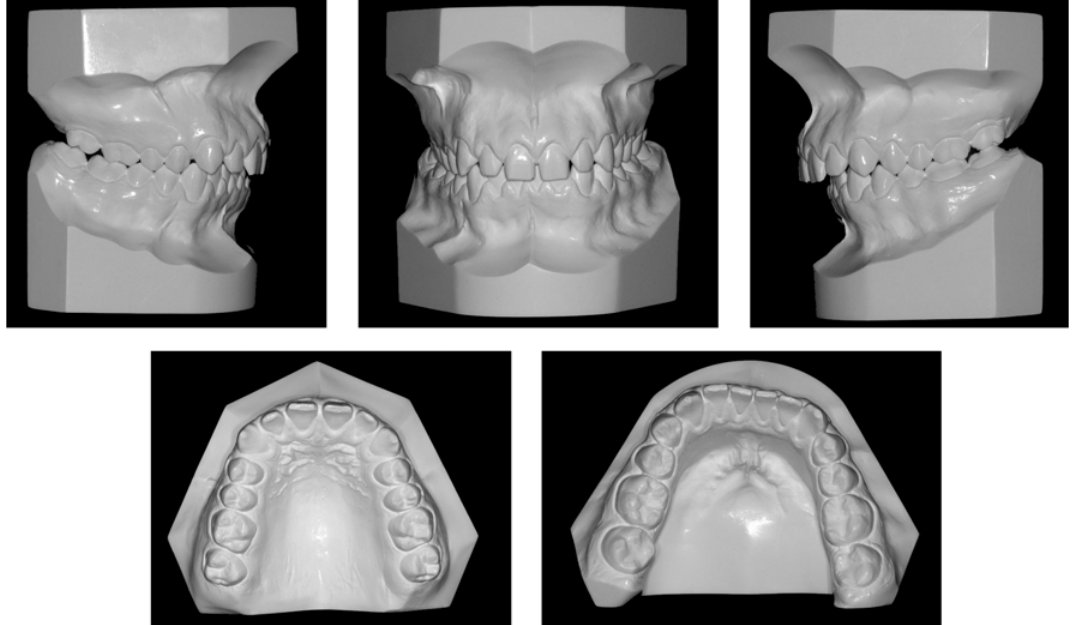
FIGURE 2- Pretreatment study models